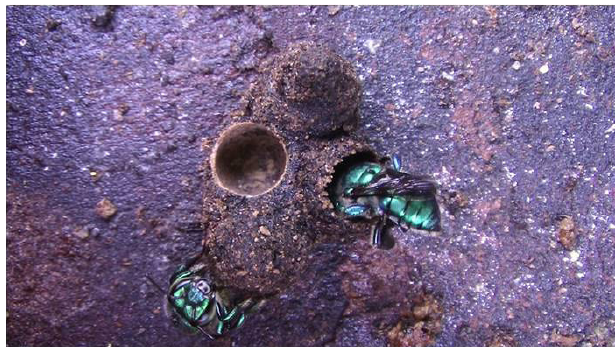
Fig 3 . Nest of Euglossa annectans in September 2010. During this phase three females were sharing the nest (the third female is missing in the picture). The picture shows females in a matrifilial association. The mother (on the left) is observing her daughter reactivating a brood